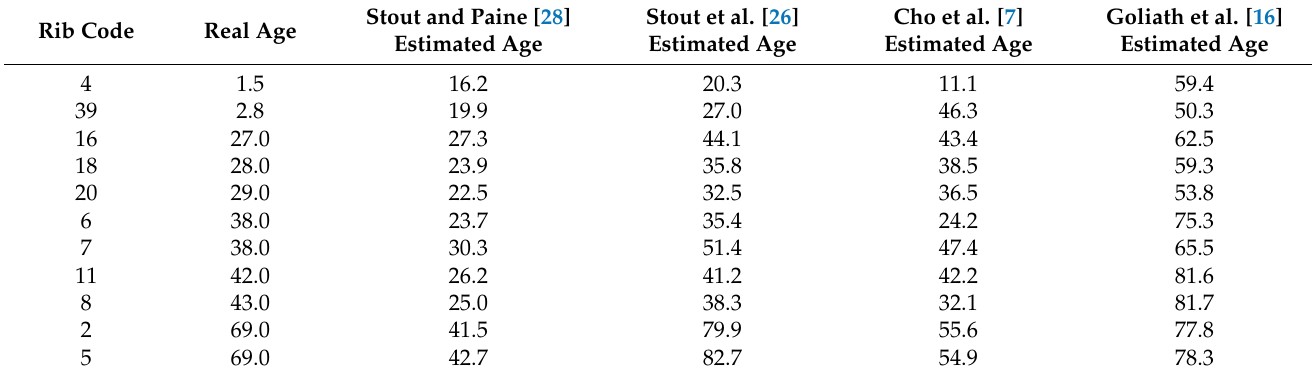
Table A1. The known and estimated age for each rib specimen by the age-estimation methods.